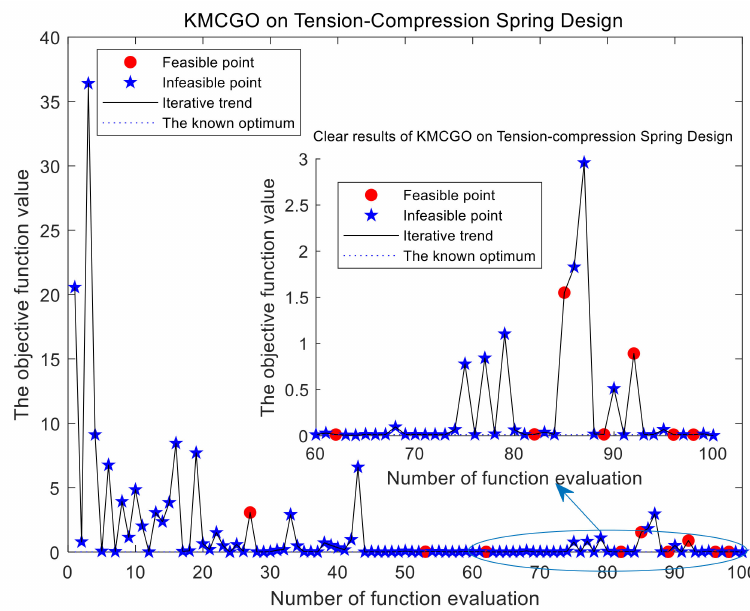
Figure 6. Iteration result of the TSD problem.